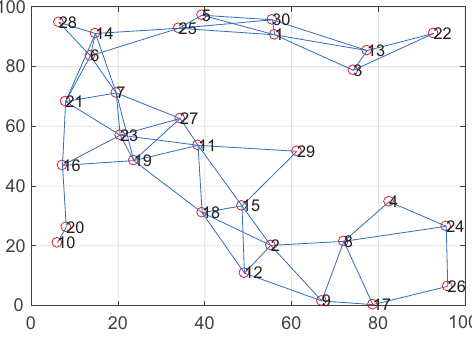
Figure 13. A random topology with 30